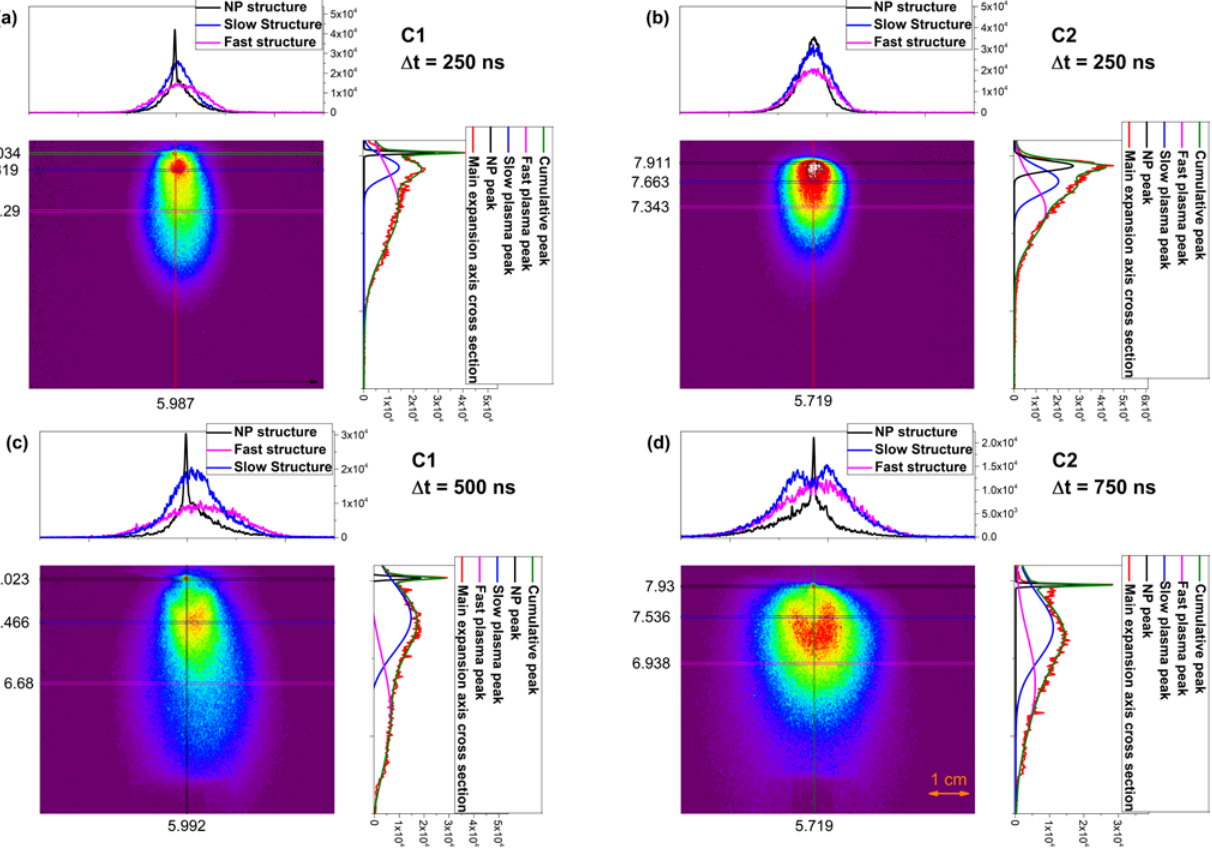
Figure 2. ICCD snapshots for C1 and C2 plasma at 250 (C1-( a ) C2 ( b )) and 750 (C2-( d ) and 500 (C1-( c ))ns delays with a cross section performed along and across several axis (NP peak—black curve, slow peak—blue curve, fast peak—magenta curve, and main expansion axis cross section—red curve).